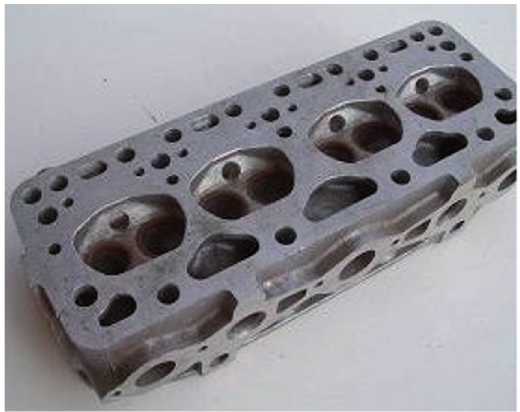
Figure 1: Engine block used in the